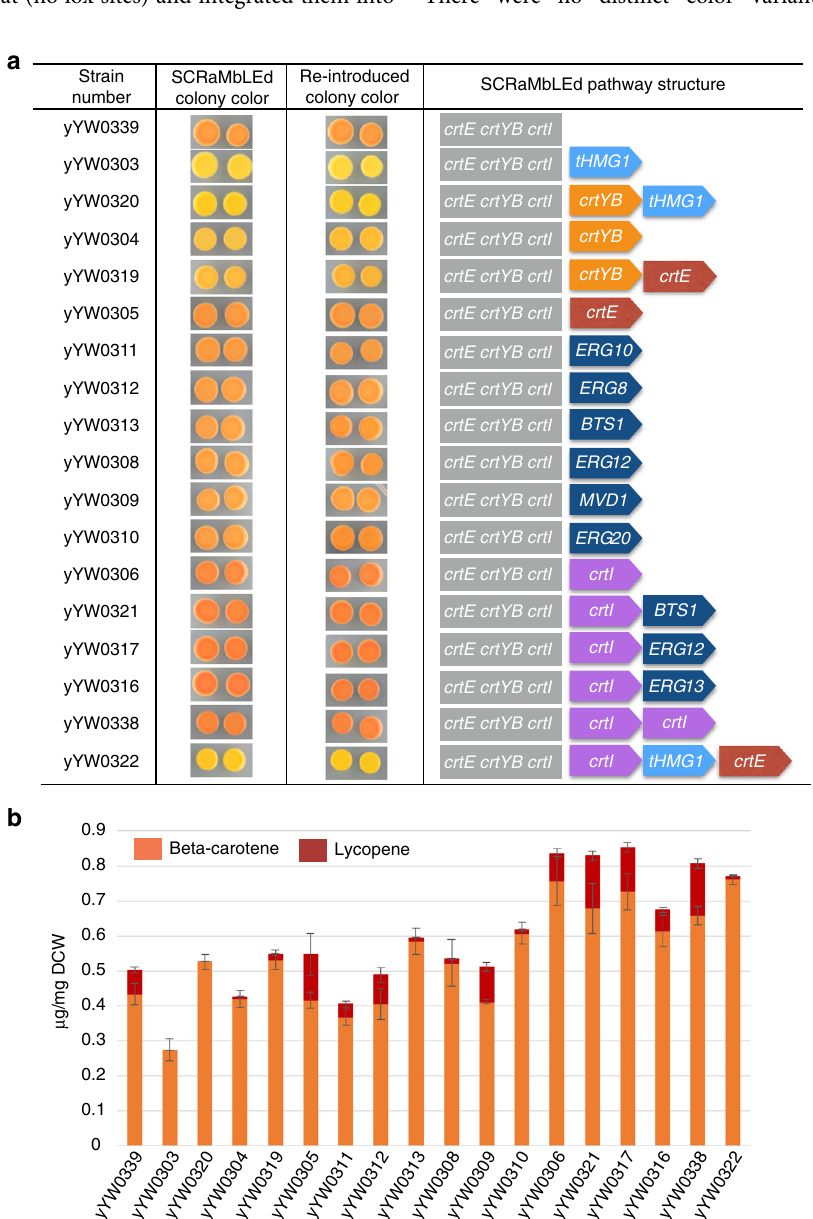
Fig. 4 Bottom-up in vitro SCRaMbLE for β -carotene pathway optimization. a Phenotype – genotype correlation of the β -carotene pathway after bottom-up in vitro SCRaMbLE (strategy 1). A total of 17 SCRaMbLEd yeast strains were isolated for testing colony color and determination of SCRaMbLEd construct sequences. The pictures of yeast color for both SCRaMbLEd strains and strains with re-introduced SCRaMbLEd plasmid were taken after 3 days incubation at 30 °C on SC – Ura medium. The SCRaMbLEd pathway structure was initially analyzed by restriction enzyme digestion to check the number of insertions and PCR analysis to evaluate which genes were inserted. Primer walking sequencing was applied to verify the sequence of all recovered plasmids. yYW0339 with only a URA3 gene inserted was used as a control strain. b HPLC measurement of carotenoid production for SCRaMbLEd yeast strains. Quanti fi cation was performed in biological triplicate for each strain as shown. Error bars represent standard deviation from three